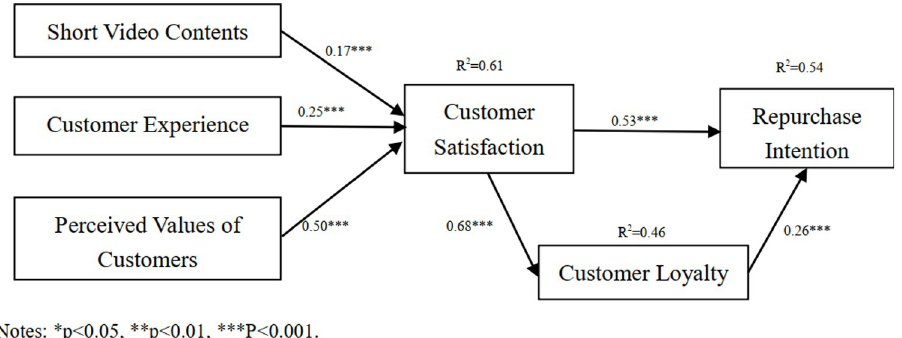
Fig 2. Results of path analysis in the structural model test. Notes: � p < 0 < 0.05, �� p < 0.01, ��� p <